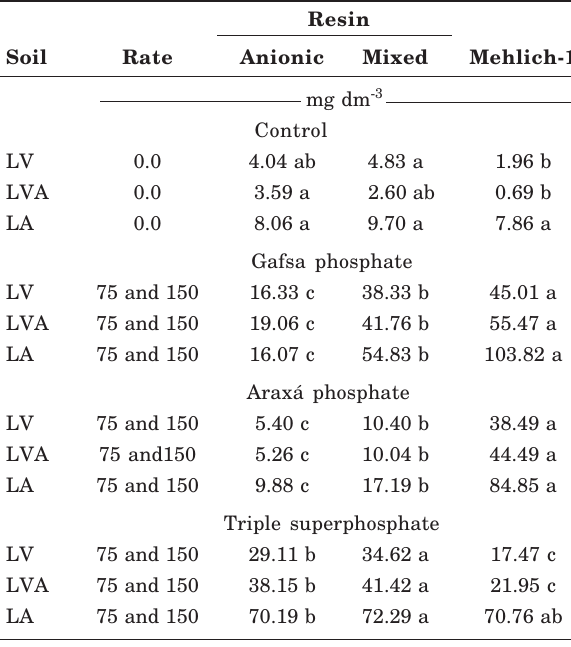
Table 7. Available phosphorus by the three tested extractants, considering rate 0 and mean P rates of 75 and 150 mg dm -3 , and mean contact times, for rock phosphates from Gafsa and Araxá and Triple superphosphate